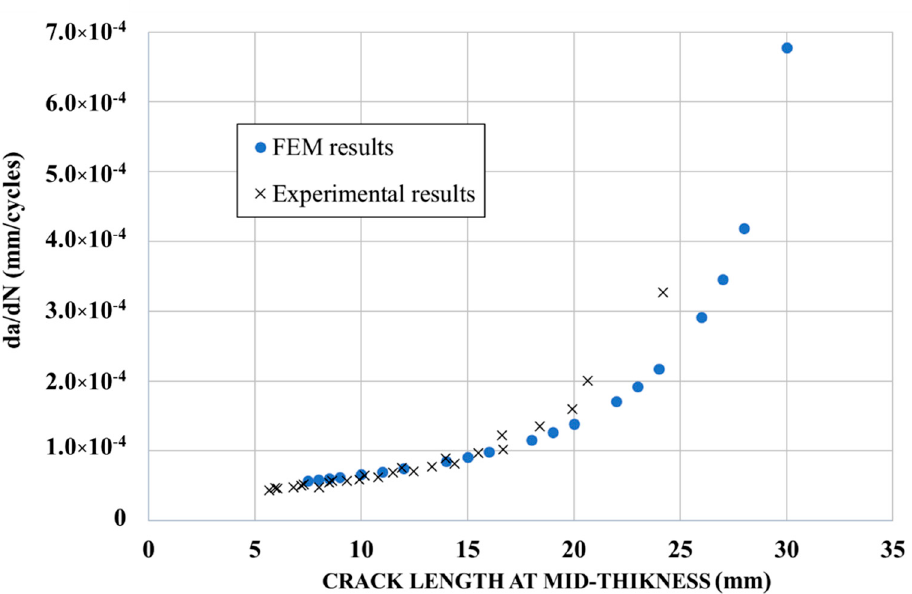
Figure 7. Crack growth curve for un-strengthened specimens.